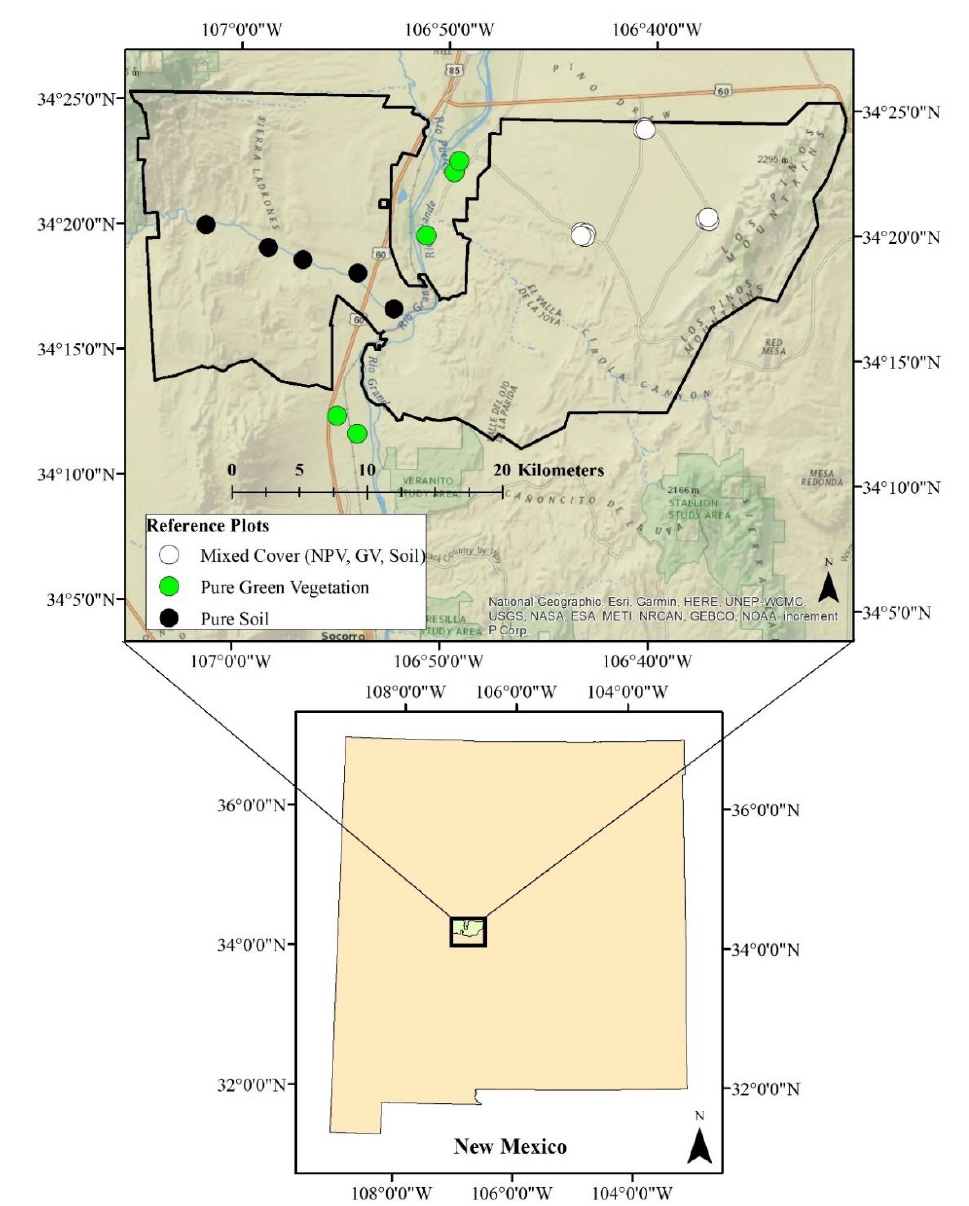
Figure 1. Map of study area, with SNWR boundary in black. Circles are reference plots used to assess accuracy of MESMA-derived fractional images. White circles are mixed cover plots derived from 2019 UAS imagery; green and black circles are pure vegetation and soil plots, respectively, derived from 2019 Landsat 8 OLI imagery.